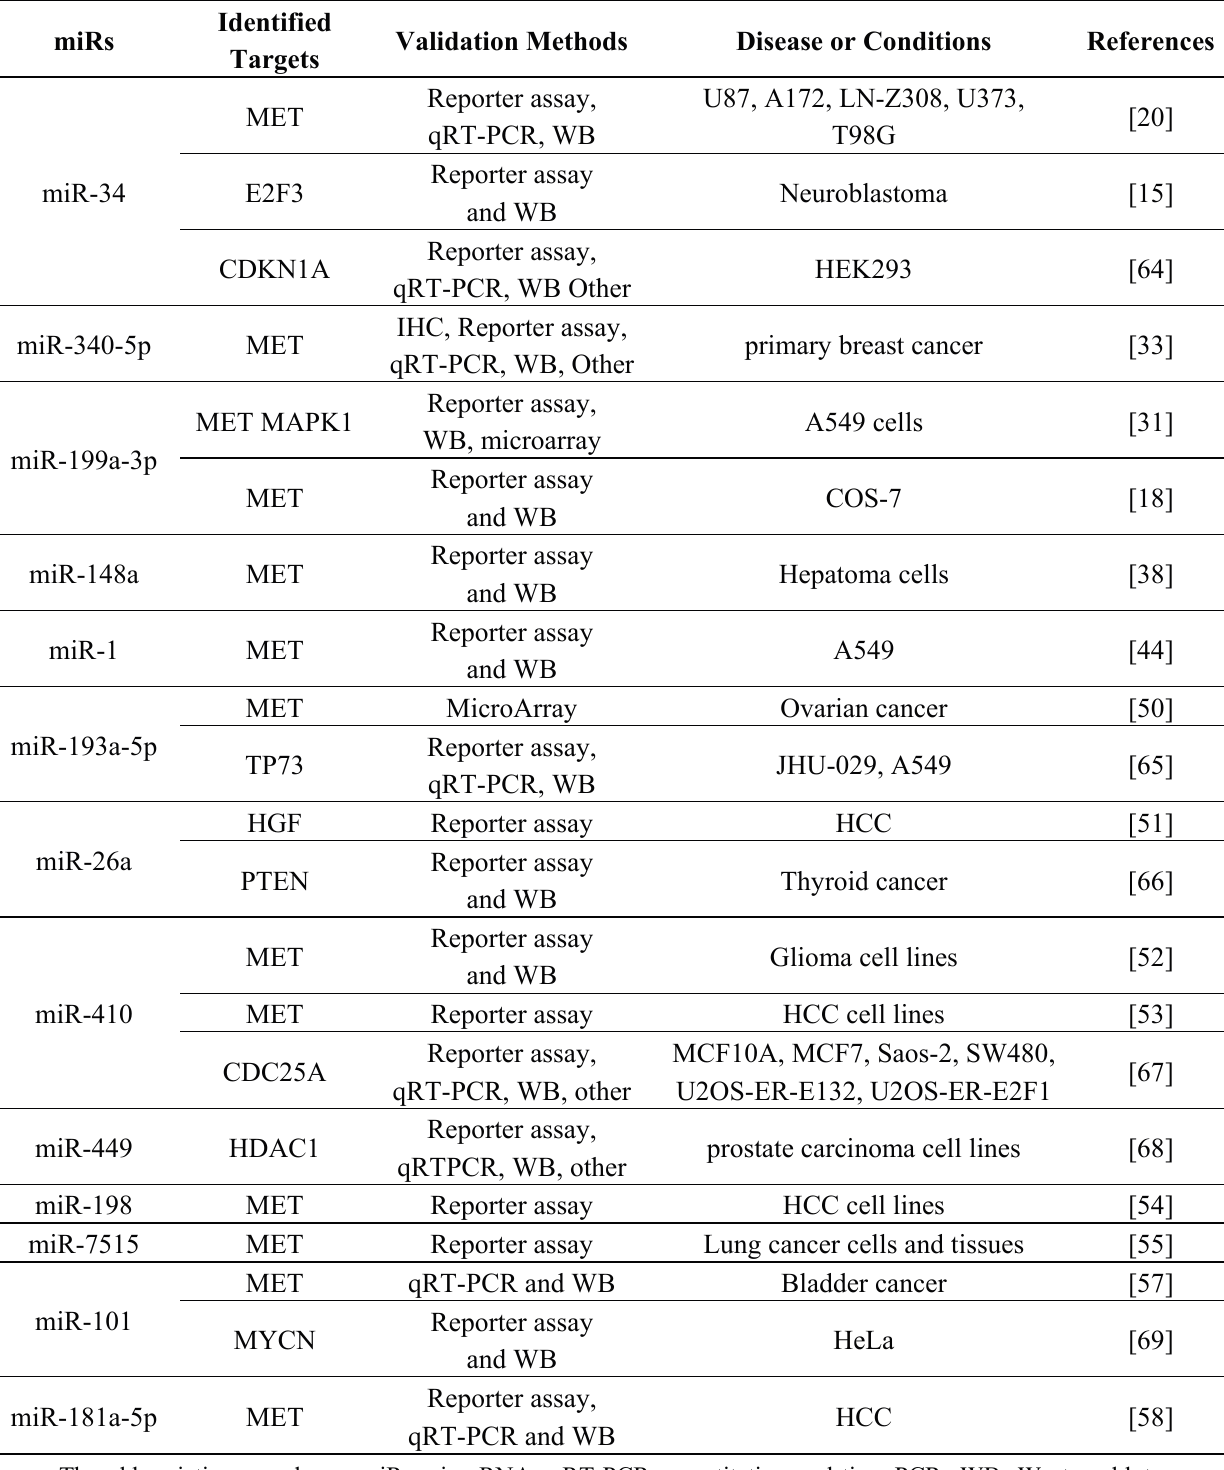
Table 1. miRs targeting